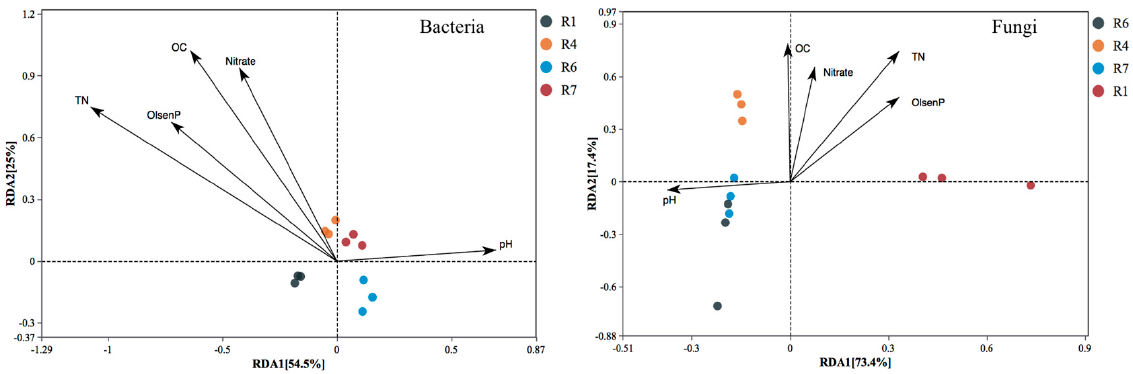
Figure 5. RDA of the rhizosphere bacterial community (left part) and fungal community (right part) of different compartments across the different varieties (1,6 indicate the rot-conducive variety; 4,7 indicate the rot-suppressive variety) and farming modes (1,4 belong to monoculture mode; 6,7 be- long to rotation mode).